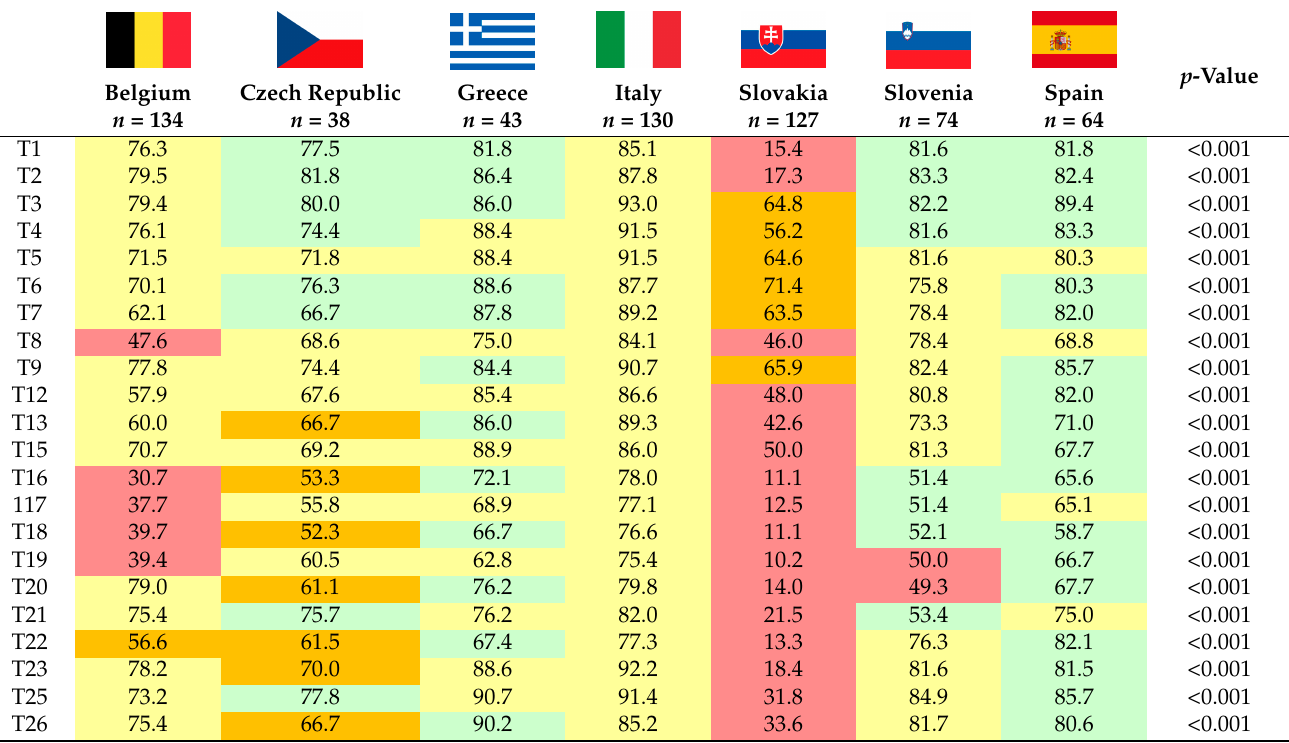
Table 5 . Presentation of 26 tasks within seven $ pharmaceutical care domains considered to be nurses’ tasks in order to obtain best quality of care and patient outcomes by at least 60% of the respondents, split up for 7 countries.